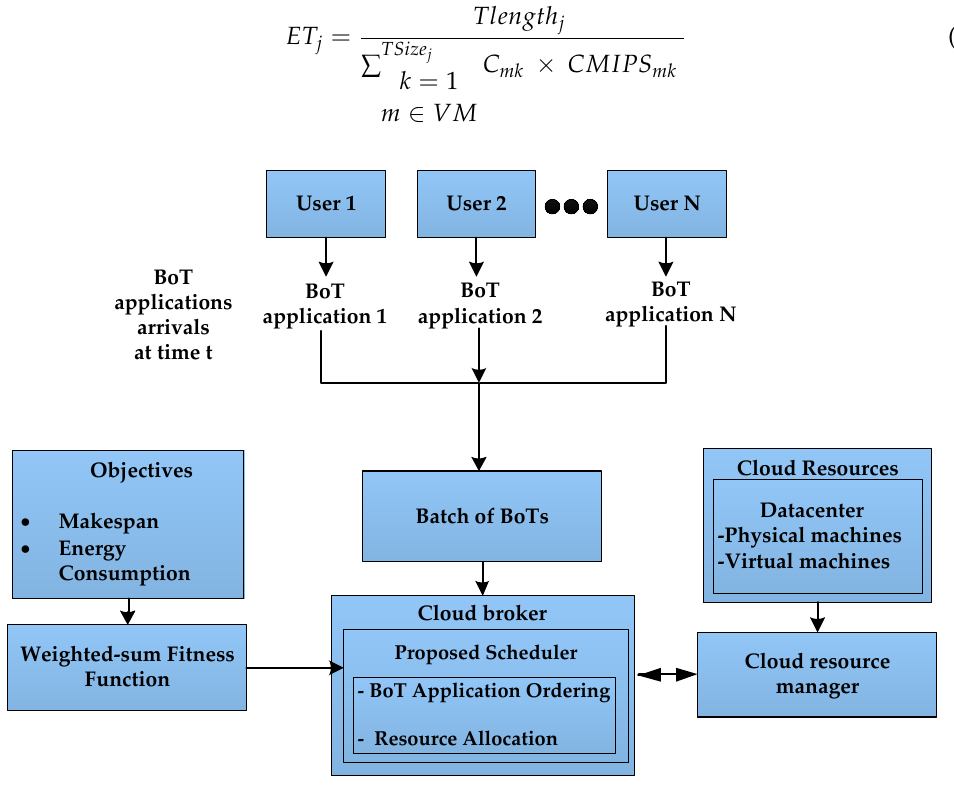
Figure 1. Proposed scheduling model using